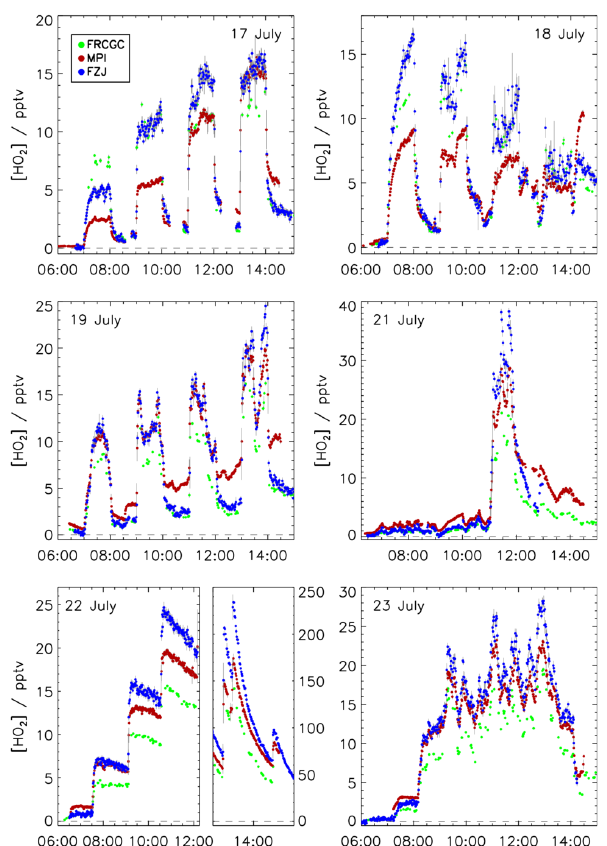
Fig. 7. Same as Fig. 6 for all SAPHIR chamber experiments. Pe- riods during which trace gases were mixed into the chamber with a high flow of zero air were excluded from the analysis (see e.g. 17